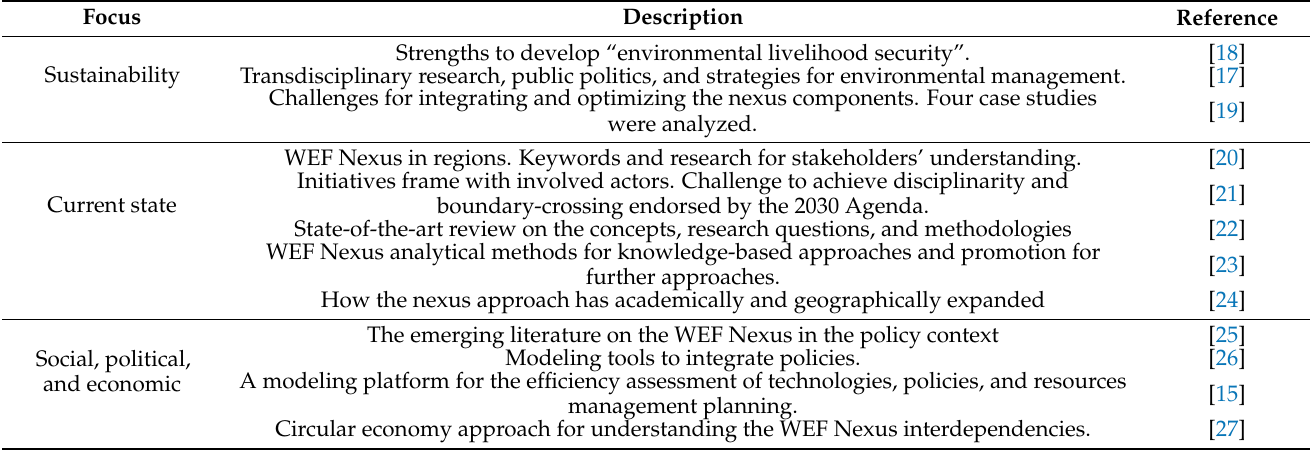
Table 1. Some relevant reviews about the Water–Energy–Food Nexus